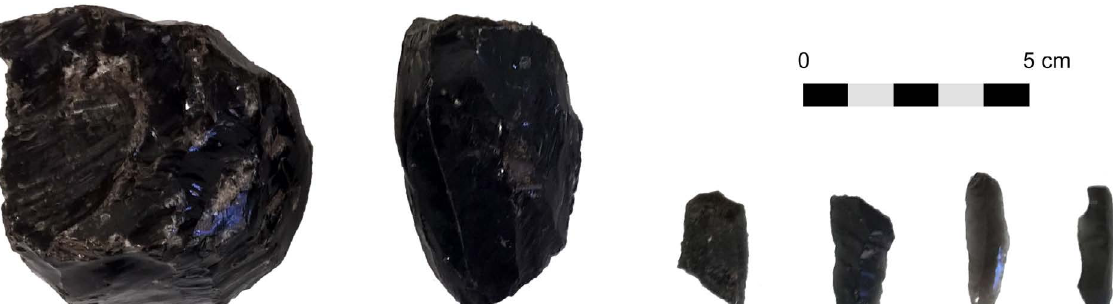
Figure 3: Artifacts from San Leonardo di Cutro, near Crotone, Calabria. Prepared cores (see particularly the second artifact from left for a core partially used to produce blades as those to the right) are frequent in Calabria, unlike